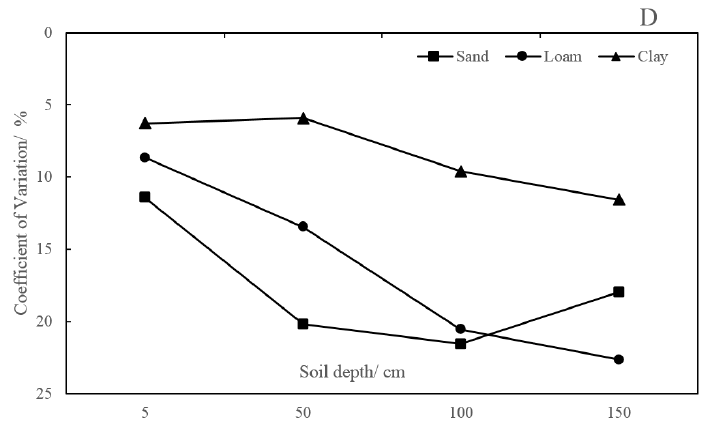
Figure 3. Different depth soil volume water content dynamic. ( A ) Sand soil; ( B ) loam soil; ( C ) clay soil; ( D ) C.V.